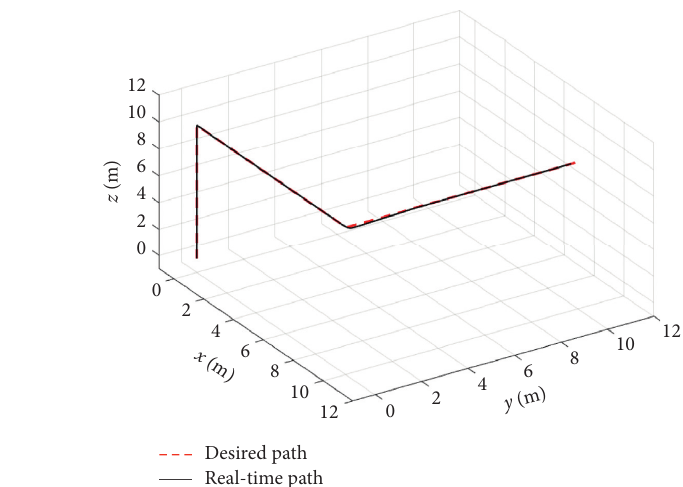
Figure 11: Curve of trajectory tracking.